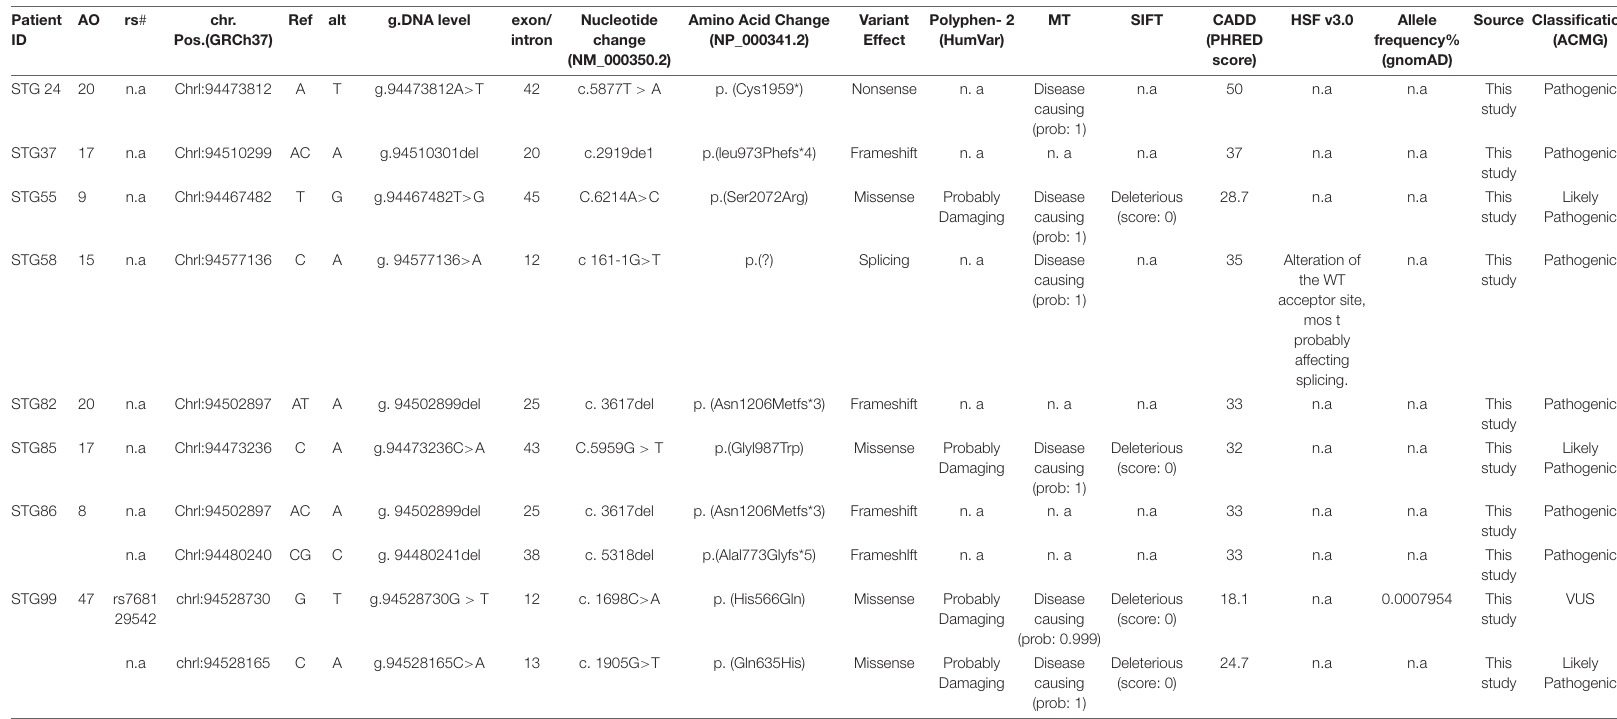
Eight probands carried nine heterozygous variants not previously associated with STGD. chr, chromosome; pos, position; ref, reference; alt, alteration; AO, age of onset; Polyphen- 2, polymorphism phenotyping v2; MT, mutation taster; CADD, combined annotation dependent depletion; SIFT, sorting intolerant from tolerant; HSF, human splicing finder; gnomAD, genome aggregation database; n.a, not available. The symbol “*” is part of the nomenclature (HGVS) to call the change at the protein